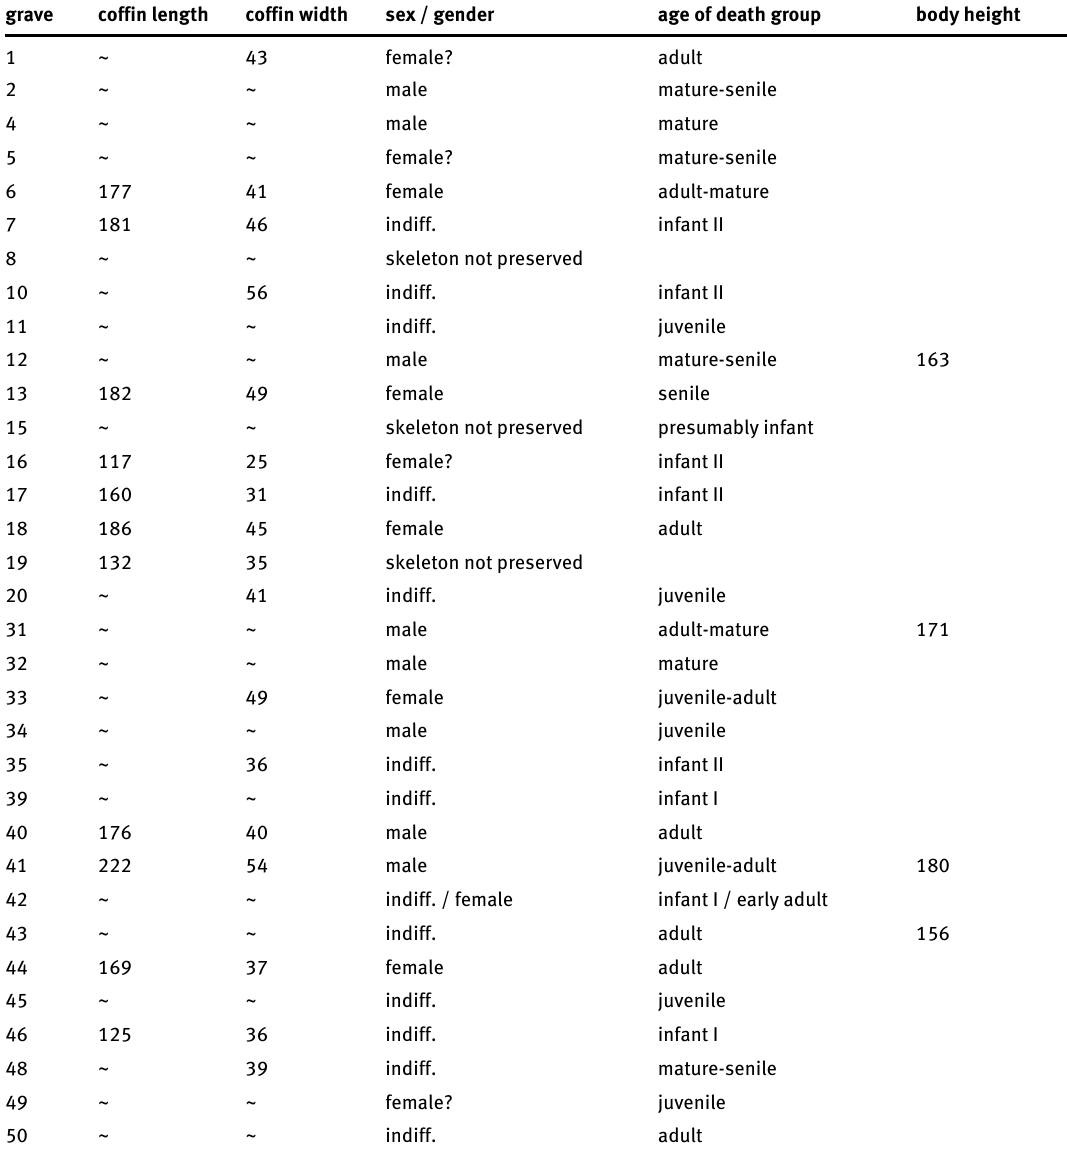
Table 1: Tabular presentation of the coffins’ dimensions, gender, age at death and body heights (~: coffin length or width cannot be